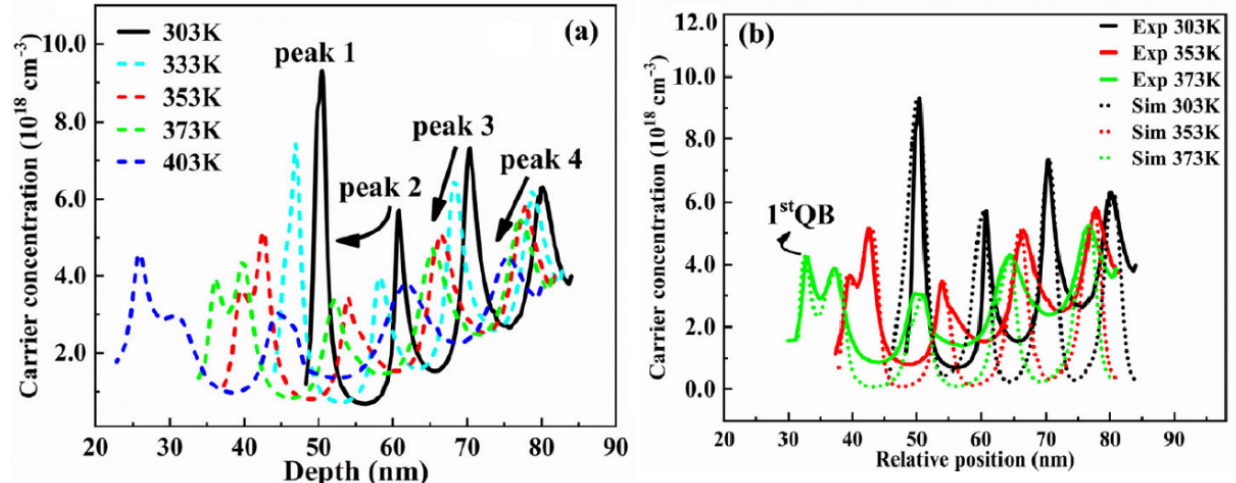
Figure 20. ( a ) The ACD profiles of 276 nm LED at different temperatures, obtained from CV measurements at 1 MHz versus depletion depth ( b ) 1D simulation and experimental data of ACD profiles. [55] Copyright 2022, Springer.